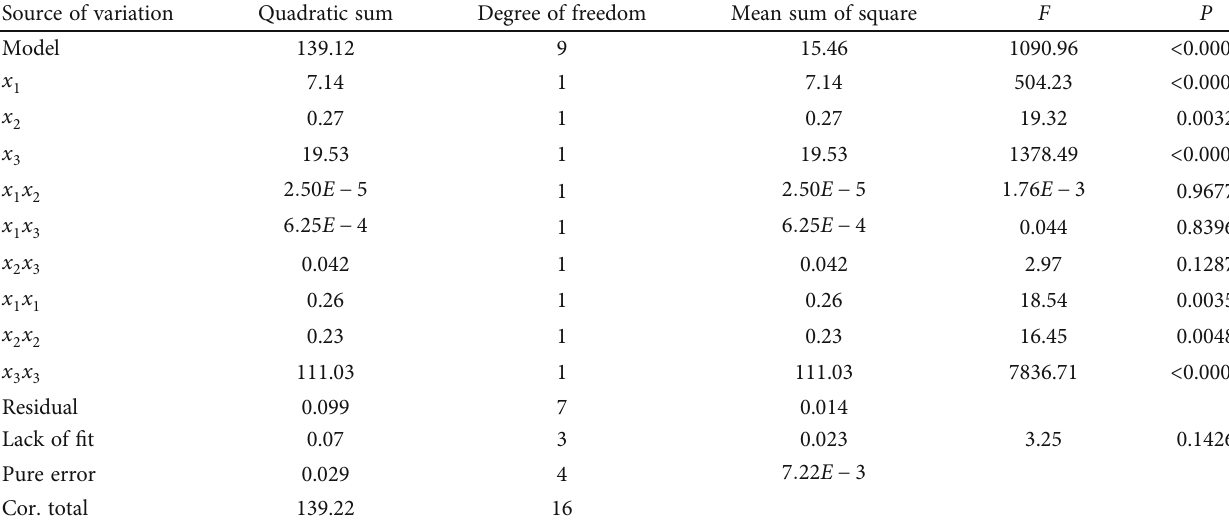
Table 5: ANOVA table for the regression